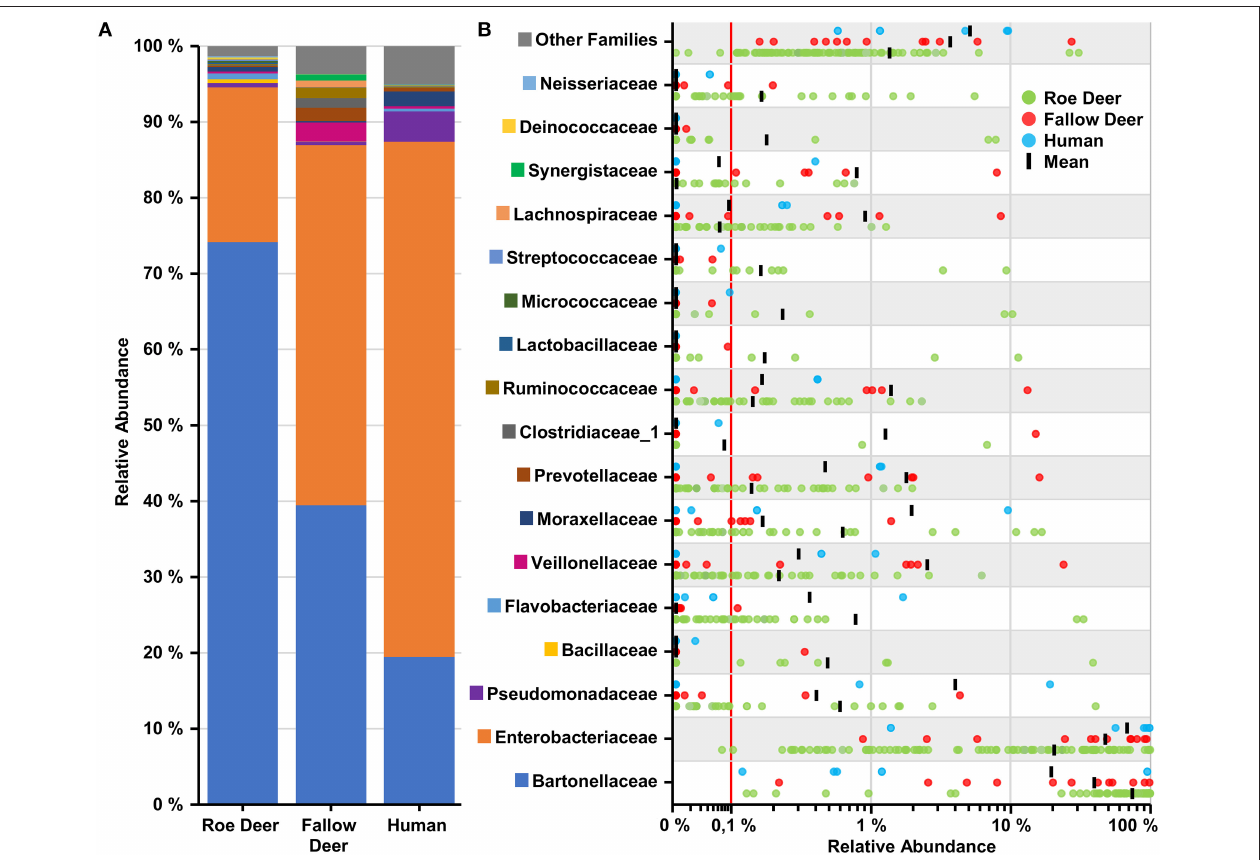
FIGURE 4 | Overview of top 17 families found in deer keds. (A) Cumulative bar charts comparing relative family abundances for deer keds collected from row deer, fallow deer and humans. (B) Variation in relative abundance of each family in deer keds samples. Red line shows cutoff for noise. Families not in the top 17 by relative abundance are categorized as other